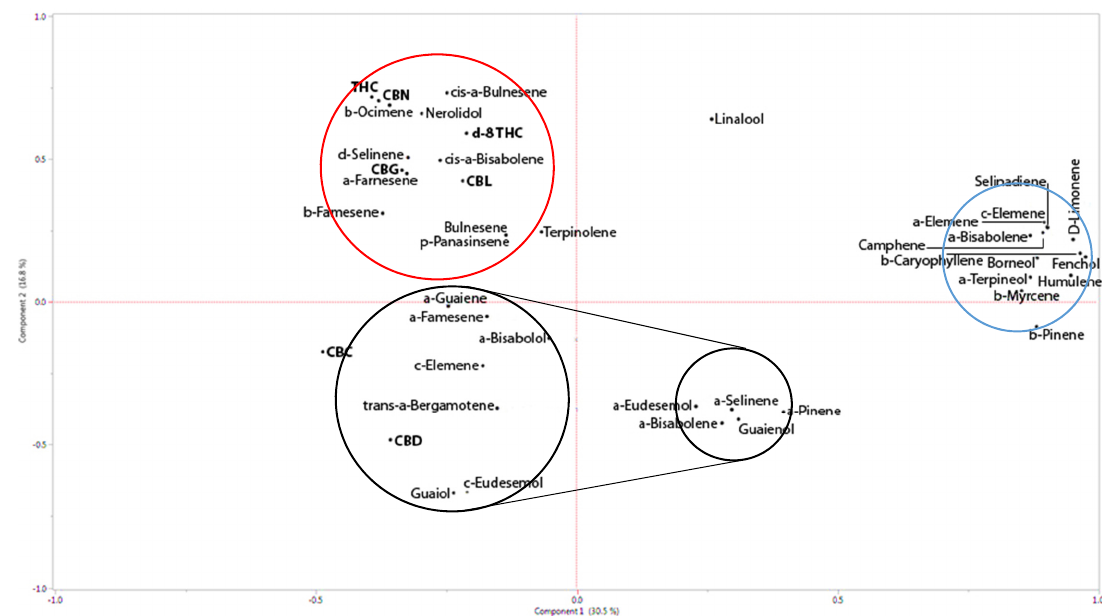
Figure 1. Principal Components Analysis (PCA) with phytocannabinoid–phytocannabinoid and phytocannabinoid–terpenoid correlations calculated for THCA and CBDA affinity. (For information regarding specific strains and chemotyping, see Supplementary Table S1). THCA co-related compounds are circled in red, while CBDA co-related compounds are circled in black. Strong correlations are indicated by larger circles, smaller correlations with smaller circles. Independent compounds, showing weak correlations to either THCA or CBDA are circled in blue. THCA: ∆ 9 -tetrahydrocannabinolic acid; CBDA: cannabidiolic acid.